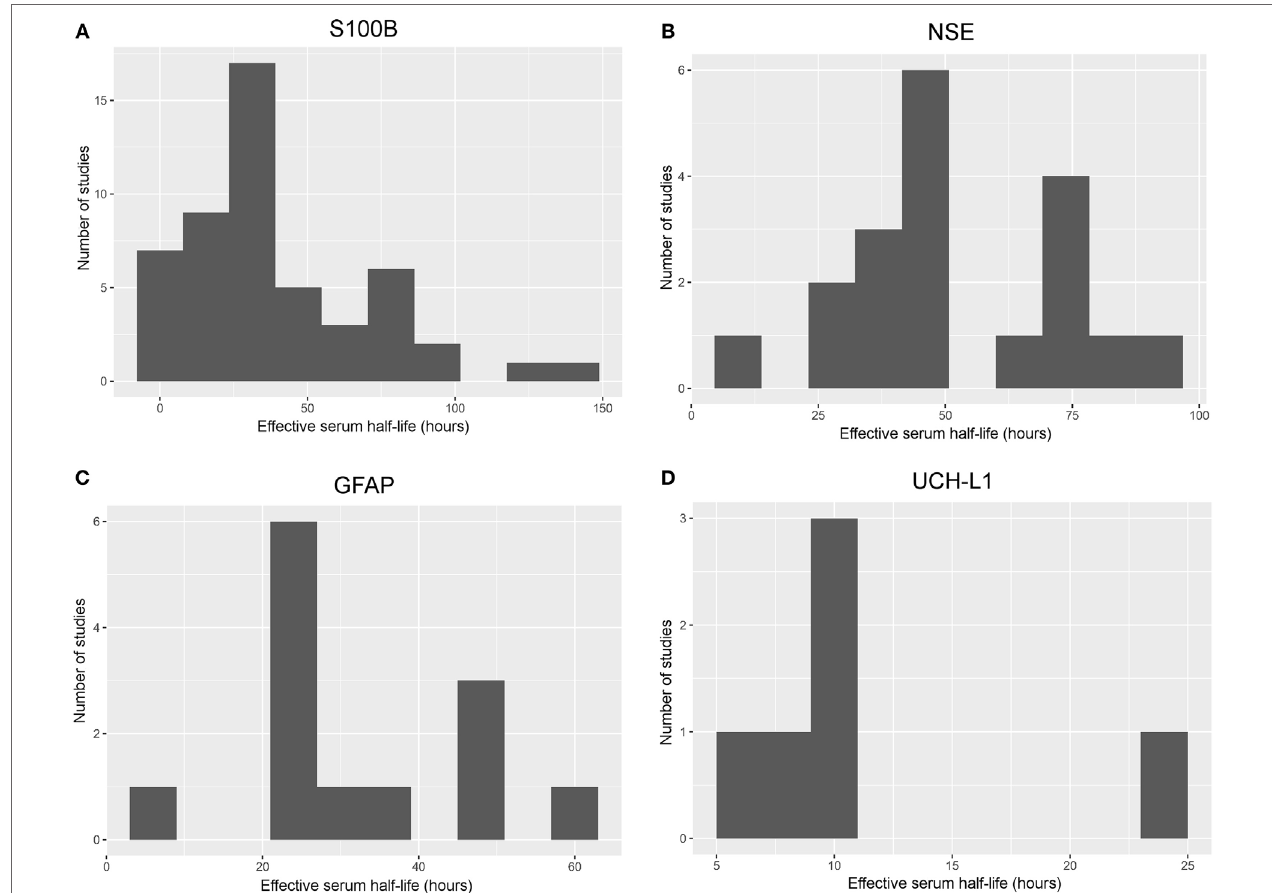
FigURe 2 | Histograms of frequency of effective serum half-life in different studies. Histograms illustrating the aggregated effective serum half-lives as derived from the different studies including S100B (A) , neuron-specific enolase (NSE) (B) , glial fibrillary acidic protein (GFAP) (C) , and ubiquitin carboxy-terminal hydrolase L1 (UCH-L1) (D) . Studies with a sampling frequency of 24 h or shorter and a valid estimate of the effective serum half-life were included. The bin size is set to 10 h in order to easily visualize trends; a relatively short effective serum half-life for S100B and UCH-L1, while it was longer for NSE and GFAP. An effective serum half-life for neurofilament light could not be included as it was impossible to estimate from the available